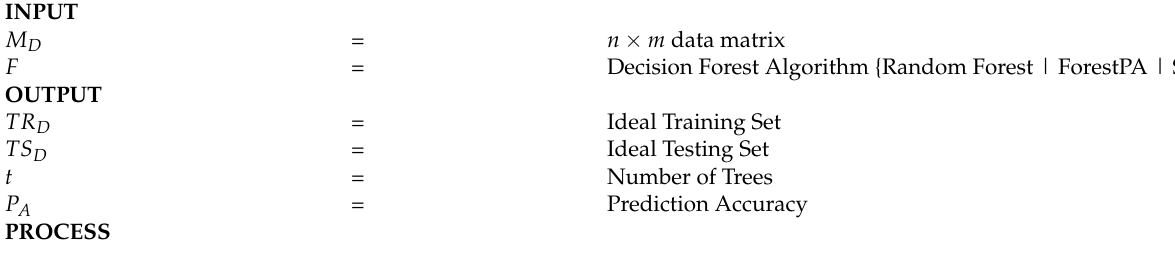
Table 4. The process of decision forests based Parkinson’s